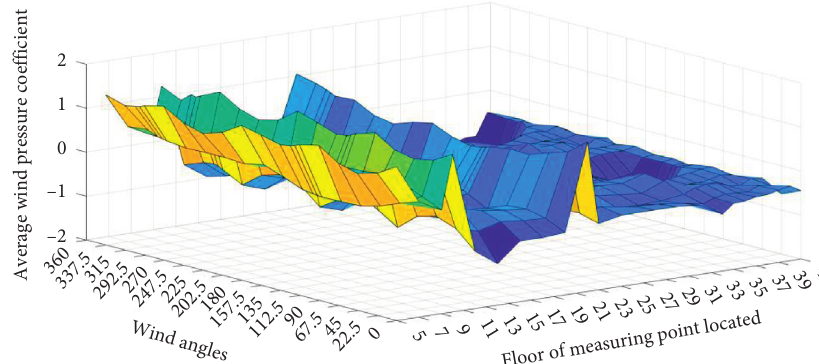
Figure 14: Mean wind pressure coefficient.